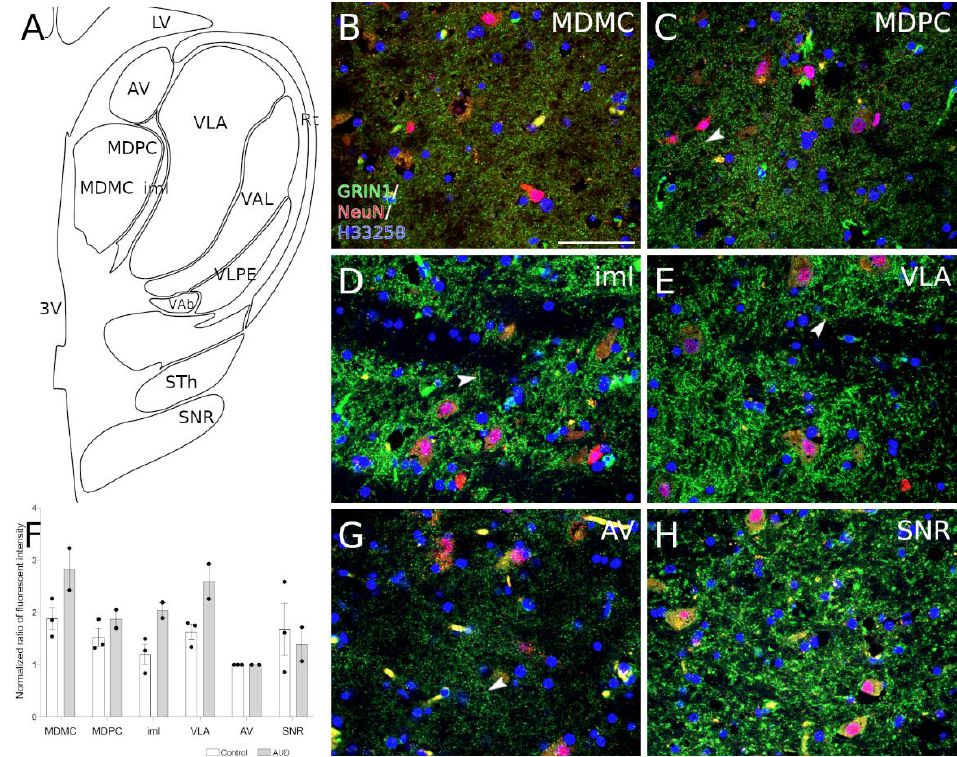
Figure 1. GRIN1 expression in the human thalamic region. ( A ) schematic drawing from−16.83 MNI displaying thalamic nuclei. ( B – E , G , H ) representative images show immunohistochemical staining of GRIN1 (green) and neuronal nuclei (red) from selected thalamic nuclei. Localization of GRIN1 protein is observable as puncta. ( C , D , E , H ) in the nuclei where the expression of GRIN1 is strongest we observe periodic localization of GRIN1 (arrowheads). Cell nuclei were stained with H33258 (blue). ( F ) graph shows the average normalized ratio of fluorescence intensity from analyzed structures to ante- roventral thalamic nucleus (see section in material and methods). Abbreviations: 3V, third ventricle; AV, anteroventral thalamic nucleus; iml, internal medullary lamina of the thalamus; LV, lateral ventricle; MDMC, mediodorsal thalamic nucleus, magnocellular part; MDPC, mediodorsal thalamic nucleus, parvicellular part; Rt, reticular thalamic nucleus; SNR, substantia nigra pars reticulata; STh, subthalamic nuclei; VAb, basal ventroanterior nucleus; VAL, lateral ventroanterior nucleus; VLA, anterior ventrolateral nucleus; VLPE, posterior ventrolateral nucleus, external part. Scalebar: 50 μm.